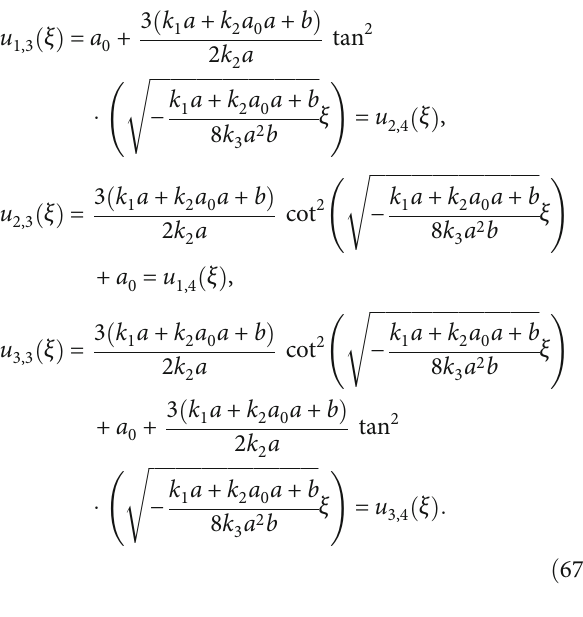
ð x , t Þ of Equation (57). 1,1